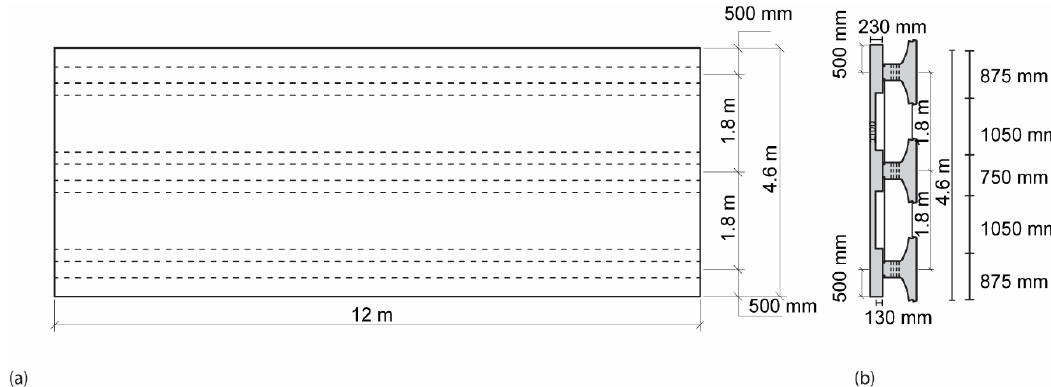
Figure 4. Overview of the second 1:2 scale setup: ( a ) top view; ( b ) cross-section view. Figure adapted from Reference [37]. Reprinted with permission. This figure was originally published in Vol. 116 of the ACI Structural Journal.